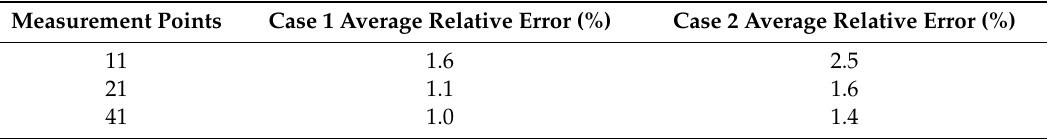
Figure 7. Identification results of di ff erent measurement points for inversion results of case 2. Table 2. Impacts of di ff erent measurement points of cases 1 and